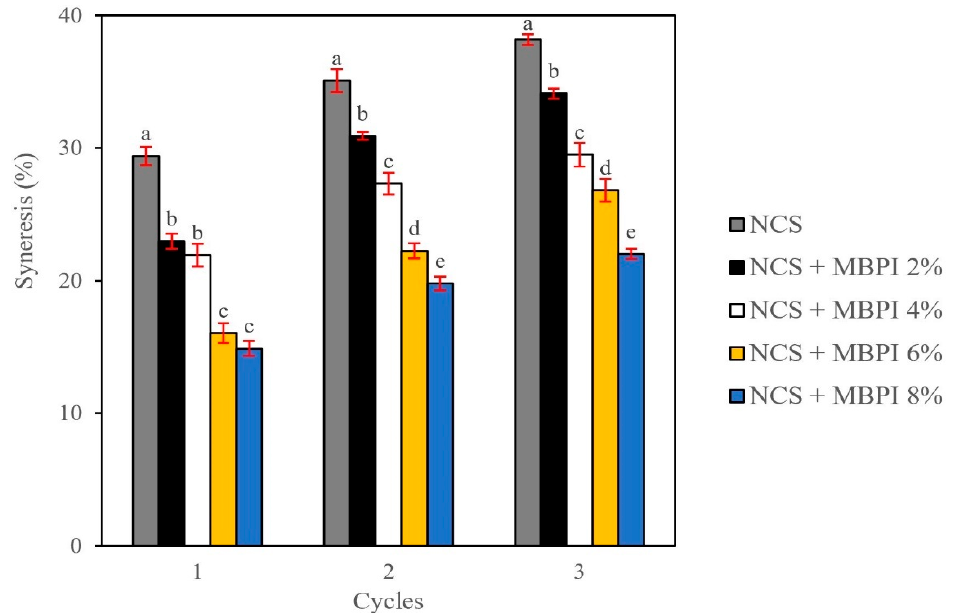
Figure 3. The freeze-thaw stability of NCS and NCS/MBPI gels in three cycles. Different letters in each cycle indicate significant differences between treatments.